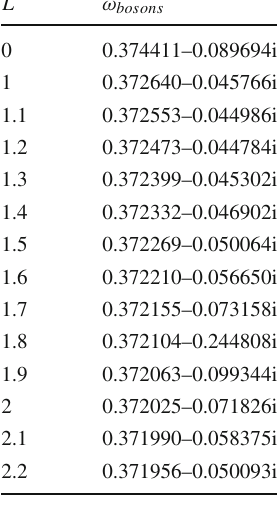
Table 1 QNMs of scalar waves in the Kerr-like black hole spacetime